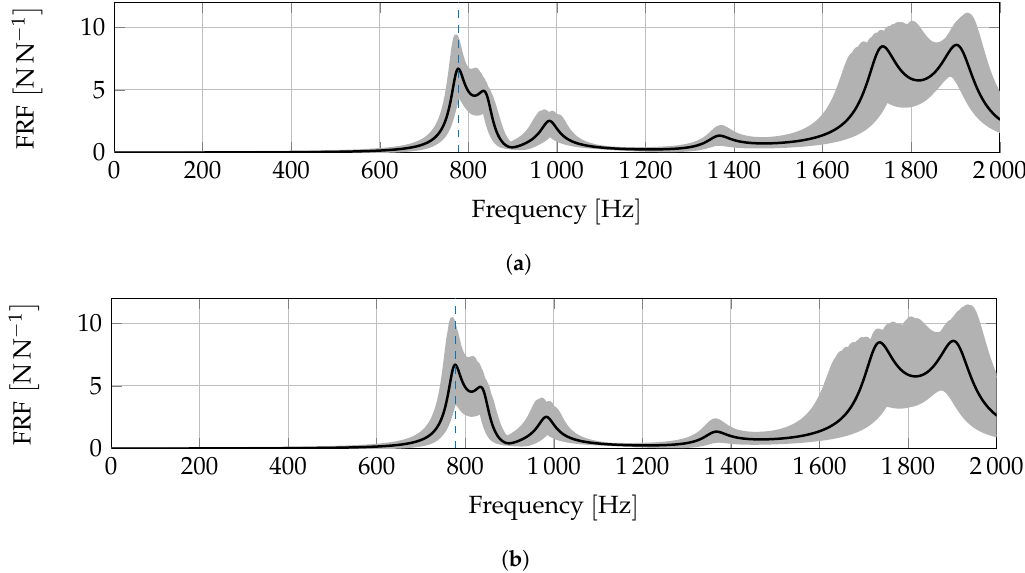
Figure 9. FRF between hard point track rod in x 2 -direction and wheel hub in x 3 -direction and Skyline of 100 designs. ( a ) Results using Direct Morphing. ( b ) Results using Box